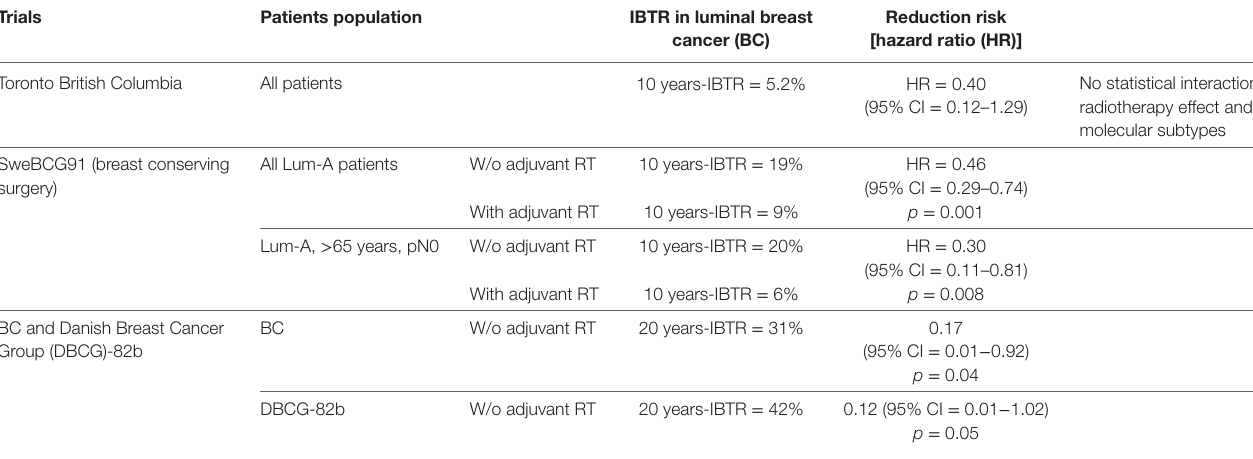
Reduction risk cancer (BC) [hazard ratio (HR)]